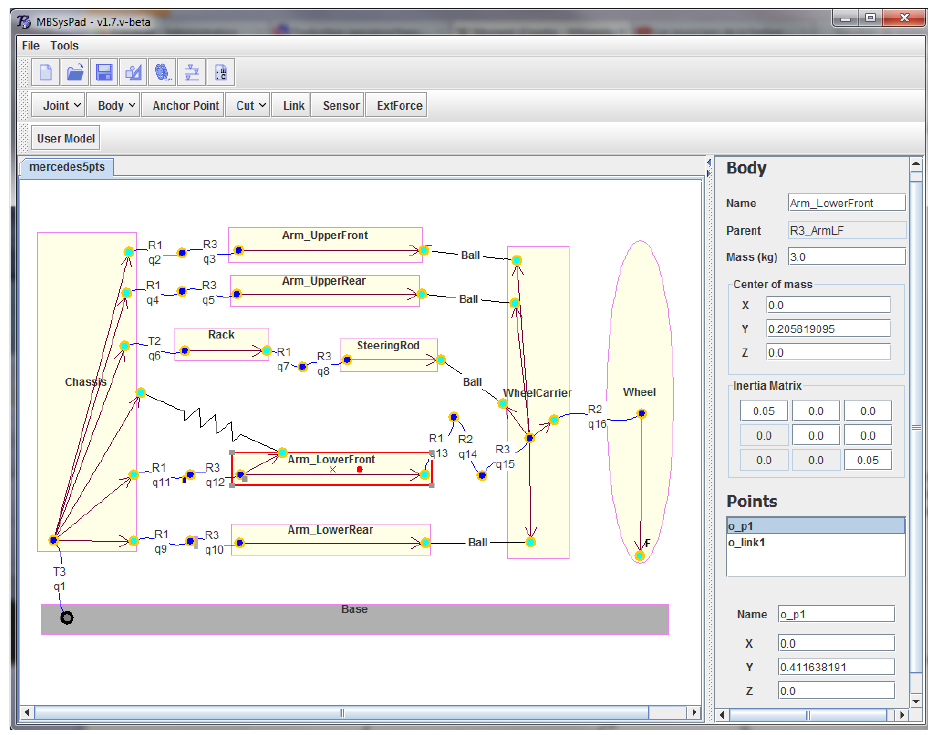
Figure 12. Representation of a 5 points suspension model in MBsysPad 2-D diagram.